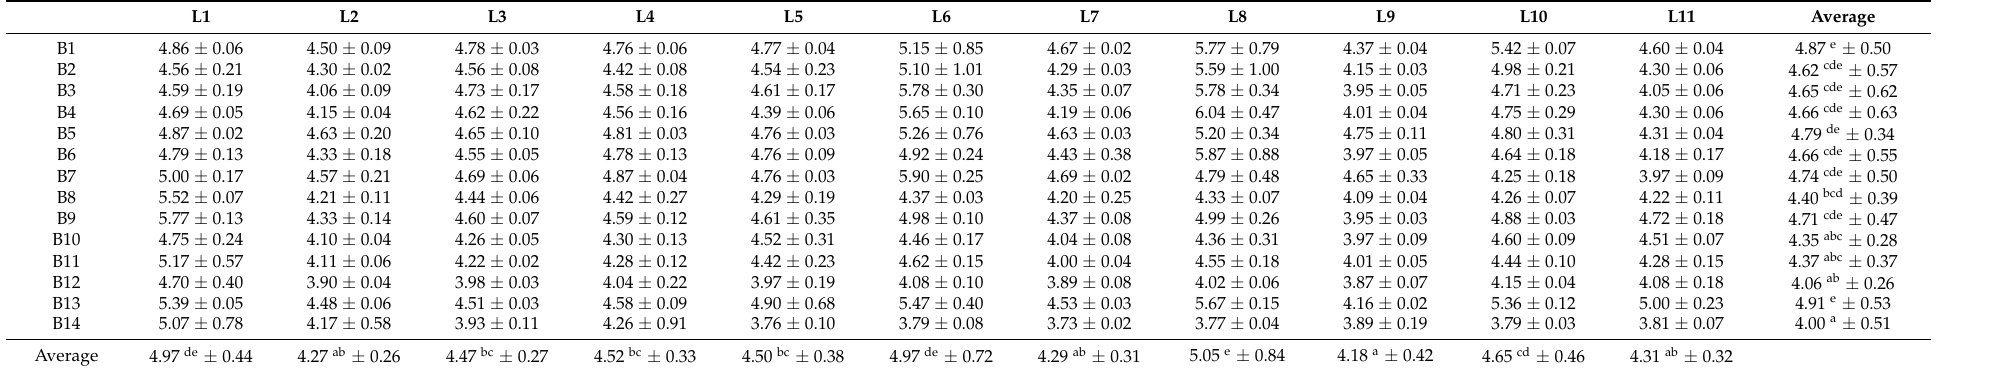
Table 3. Mean of the end-point pH values ± relevant standard deviation measured in co-cultivation with each LAB strain (from B1 to B14) crossed with each yeast strain (from L1 to L11) in reconstituted bovine sweet